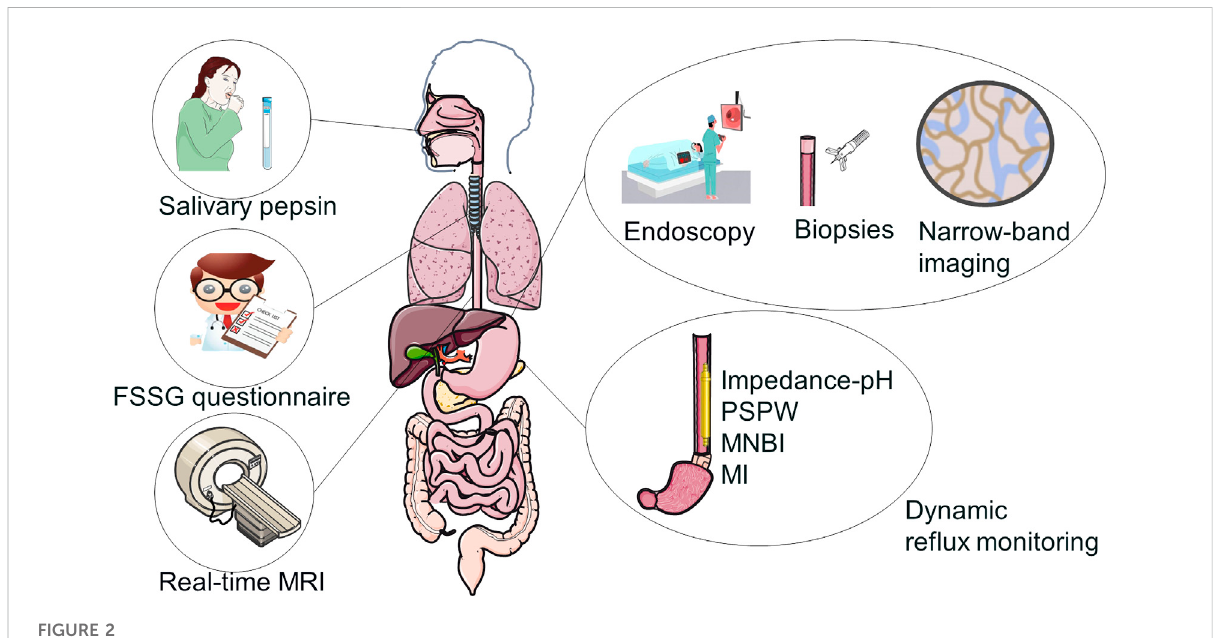
FIGURE 2 Diagnostic tests of